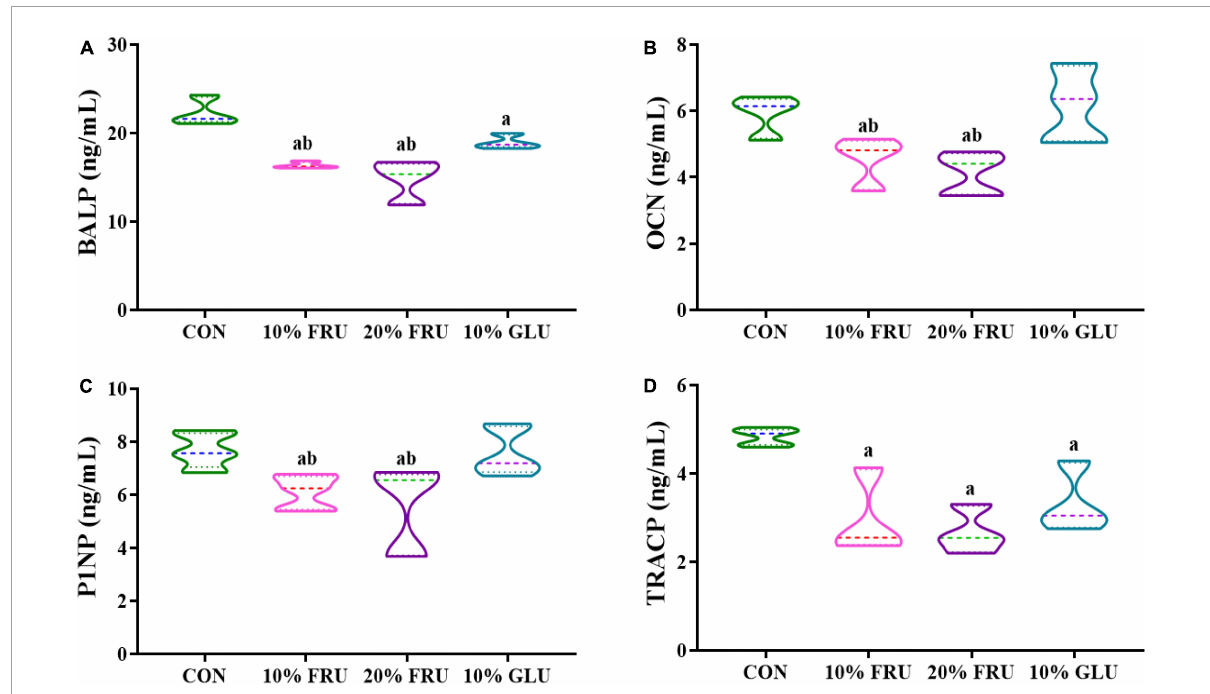
FIGURE6 Analysis of serum markers of bone formation and resorption: (A) BALP, (B) OCN, (C) P1NP, and (D) TRACP. The values were presented as mean ± SD ( n = 7); a means p < 0.05 compared with the CON group and b means p < 0.05 compared with the 10% GLU